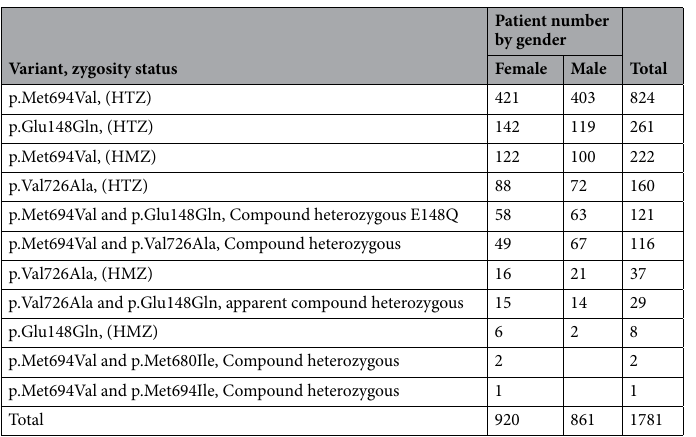
Table 1. Prevalence of common MEFV variants in Jewish FMF referrals to genetic testing between 2001 and 2017 in one referral center. HMZ homozygote, HTZ heterozygote.